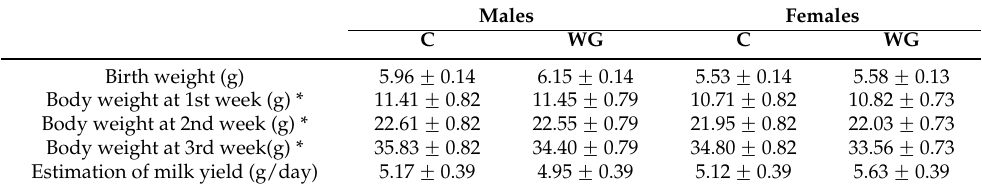
Values are means with standard errors. Birth weight data were analyzed in rats fed maternal control (C, males n = 36, females n = 36) or low quality protein (WG, males n = 39, females n = 45) diets. Body weight during lactation (1st, 2nd and 3rd weeks) were analyzed in rats fed a maternal control (C, males n = 12, females n = 12) or low quality protein (WG, males n = 13, females n = 15) diet. * Body weights were significantly influenced by study week ( p < 0.001).